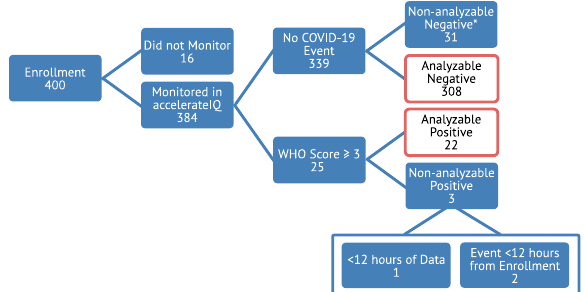
Fig. 5 The analysis fl owchart from 400 enrolled to 330 ultimately analyzed participants. The asterisk denotes 31 participants without COVID-19 events who did not have enough data to analyze, and were excluded from